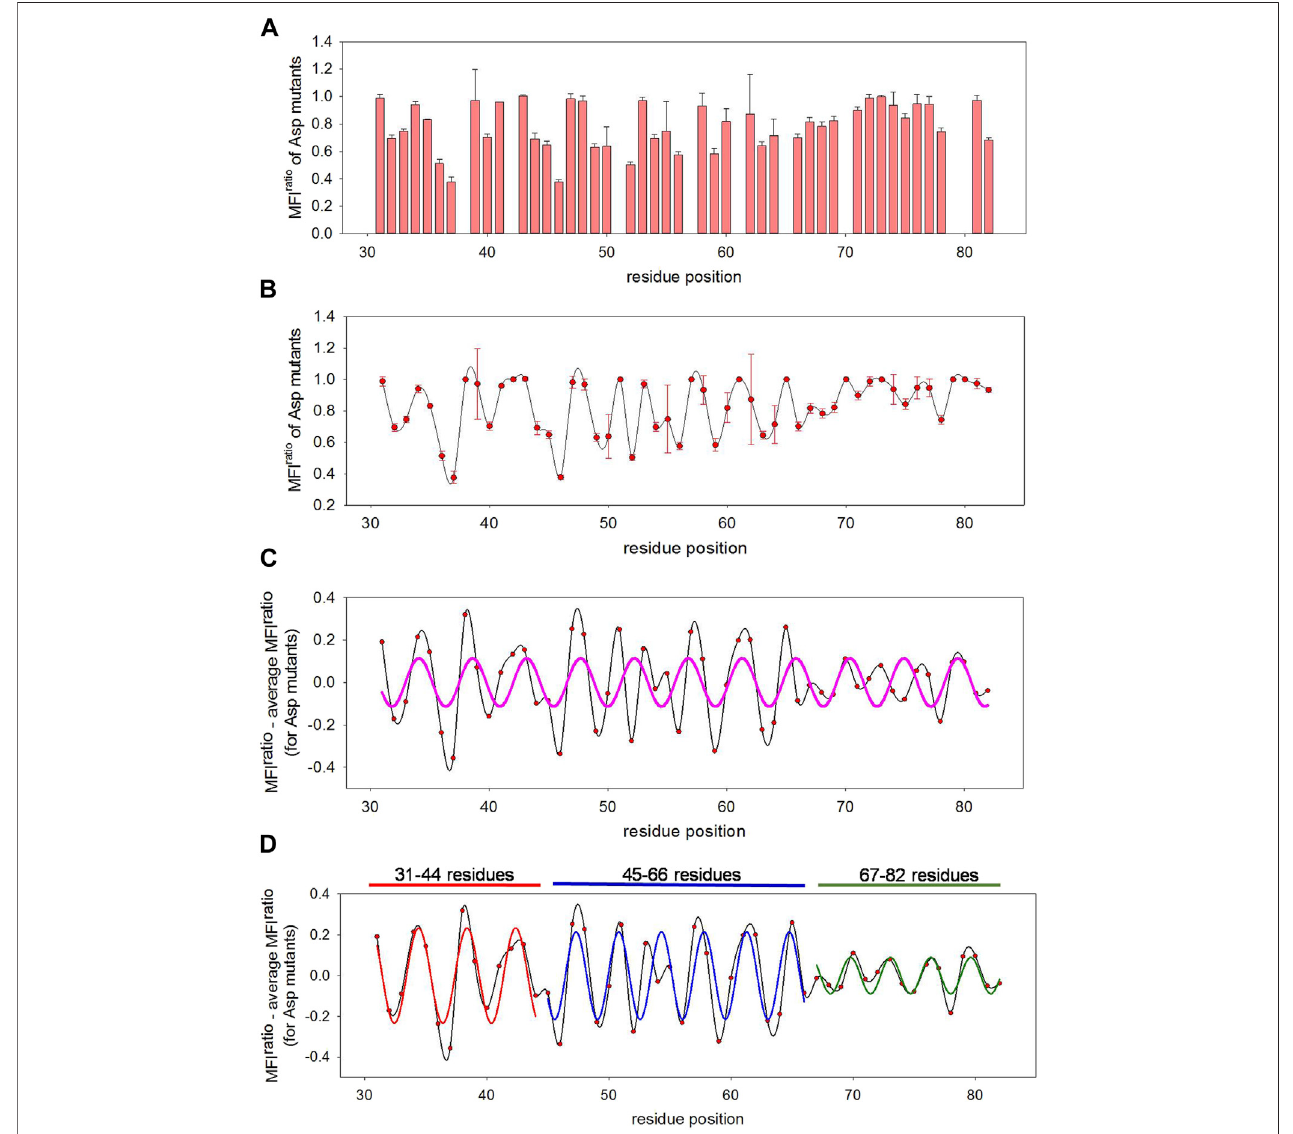
FIGURE4| PredictinglocalstructuralfeaturesattainedbydisorderedMazE6upontoxinbinding. (A) MFI ratio ofaspartatemutantsshownon-uniformdistributionof mutational effects across the protein length. The mean values of two biological replicates are plotted here. The error bars describe the standard deviations between two replicates. (B) MFI ratio of aspartate mutants (mean values in red circle, with standard deviations depicted as error bars) as a function of residue positions plotted as a spline curve (shown in black), that reveals an oscillating pattern in MazE6 mutational effects. (C) MFI ratio -MFI avg fi t to a sinusoidal curve. The MFI avg is the MFI ratio of aspartatemutantsaveragedover fi veresiduewindows.Whenasinglesinusoidalcurveis fi ttothecorrectedmutationalscoresofresidues31-82,the fi t(showninpink)is poor. (D) MFI ratio -MFI avg for residue stretches 31-44, 45-66 and 67-82 fi t to three separate sinusoidal waves. The fi ts for 31-44, 45-66 and 67-82 residue stretches are shown in red, blue and green lines respectively.